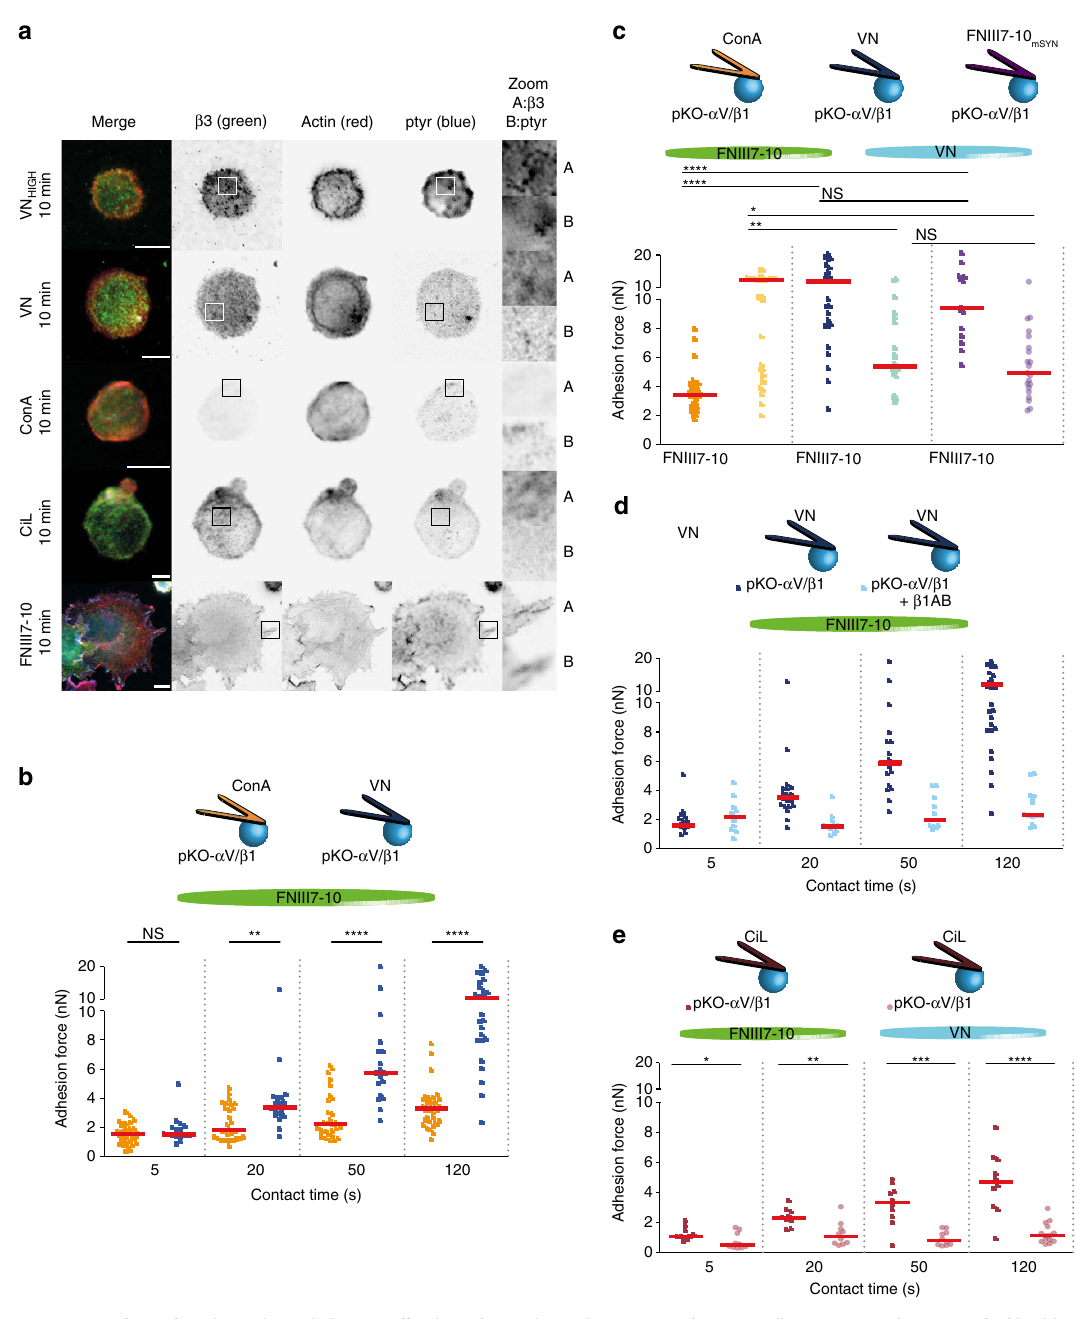
Figure 2 | Engagement of a V-class integrins reinforces adhesion of a 5 b 1 integrins to FN. ( a ) Immunofluorescence of pKO- a V/ b 1 fibroblasts seeded on VN-, ConA-, or FNIII7-10-functionalized substrates. Fibroblasts adhering to 50 m gml –1 VN (VN HIGH ), 5 m gml –1 VN diluted in ConA (VN), ConA, CiL and FNIII7-10 for 10min were stained for a V-class integrin (green), actin (red) and phospho-tyrosine (ptyr, blue) using b 3 integrin-specific antibodies for the detection of a V b 3 integrins, phalloidin and ptyr antibody, respectively (‘Methods’ section). Immunostaining of a V-class integrins and phospho-tyrosine in pKO- a V/ b 1 fibroblasts adhering to FNIII7-10-coated substrates is used as a positive control. Scale bars, 10 m m. ( b ) a V-class integrins engaged to VN augment fibroblasts adhesion to FNIII7-10. pKO- a V/ b 1 fibroblasts were either attached to ConA (yellow)- or to VN (blue)-coated cantilevers for 7–10min, then approached to the FNIII7-10-coated substrate for defined contact time and finally retracted to measure the adhesion force. ( c ) a V-class integrins engaged to FNIII7-10 could also strengthen fibroblast adhesion to FNIII7-10. pKO- a V/ b 1 fibroblasts attached either to cantilevers coated with VN (blue) or FNIII7-10 having a mutated synergy site (FNIII7-10 mSYN , violet) enhanced adhesion to FNIII7-10. ( d ) VN-stimulated fibroblasts enhance adhesion to FNIII7- 10 via a 5 b 1 integrins. pKO- a V/ b 1 fibroblasts were incubated with a a 5 b 1 integrin-blocking antibody ( b 1AB) for 30min, then attached to VN-coated cantilevers and finally approached to FNIII7-10 for defined contact time (5–120s). For VN-stimulation, ( b - d ) cantilevers were coated by 5 m gml –1 VN diluted in ConA. ( e ) a V-class integrins must be engaged to stimulate pKO- a V/ b 1 fibroblasts to strengthen adhesion to FN. Adhesion of pKO- a V/ b 1 fibroblasts attached to CiL-coated cantilevers measured to FNIII7-10 and VN. Dots show adhesion forces of single fibroblasts ( n Z 10 for each condition) and red bars their median. Statistical significances were calculated with two-tailed Mann–Whitney U -tests (**** P o 0.0001; *** P o 0.001; ** P o 0.01; * P o 0.05; NS, non-significant, P Z